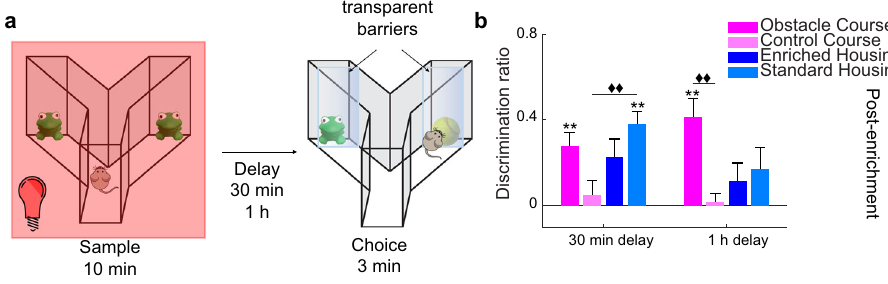
Fig. 6 CMOR: enhanced cross-modal object memory with OC training. a Schematic of the cross-modal object recognition (CMOR) experiment. b CMOR task performance. At a 30-min delay, the SH group discriminated signi fi cantly more than the CC group. The OC and SH groups discriminated the novel object above chance. With a 1-h delay, the OC group demonstrated enhanced performance relative to the CC group (Delay x group interaction p = 0.056, delay main effect p = 0.216, and group main effect p = 0.005). Only the OC group could discriminate the novel object. The experiment was implemented 4 – 4.5 months post enrichment. * p < 0.05, ** p < 0.01, *** p < 0.001 indicate signi fi cant two-tailed paired-sample t -tests (choice DR vs. sample DR). ♦♦ p < 0.01, ♦♦♦ p < 0.001 indicate a signi fi cant difference between groups (two-tailed independent samples t -test, Bonferroni correction p = 0.0083). Error bars represent s.e.m. across